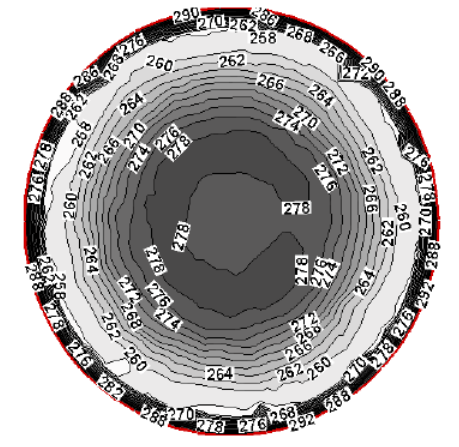
Figure 12. Contours of temperature distribution at 1.5 cm along ax- ial direction from the inlet nozzle in hot end at 5 bar inlet pressure.